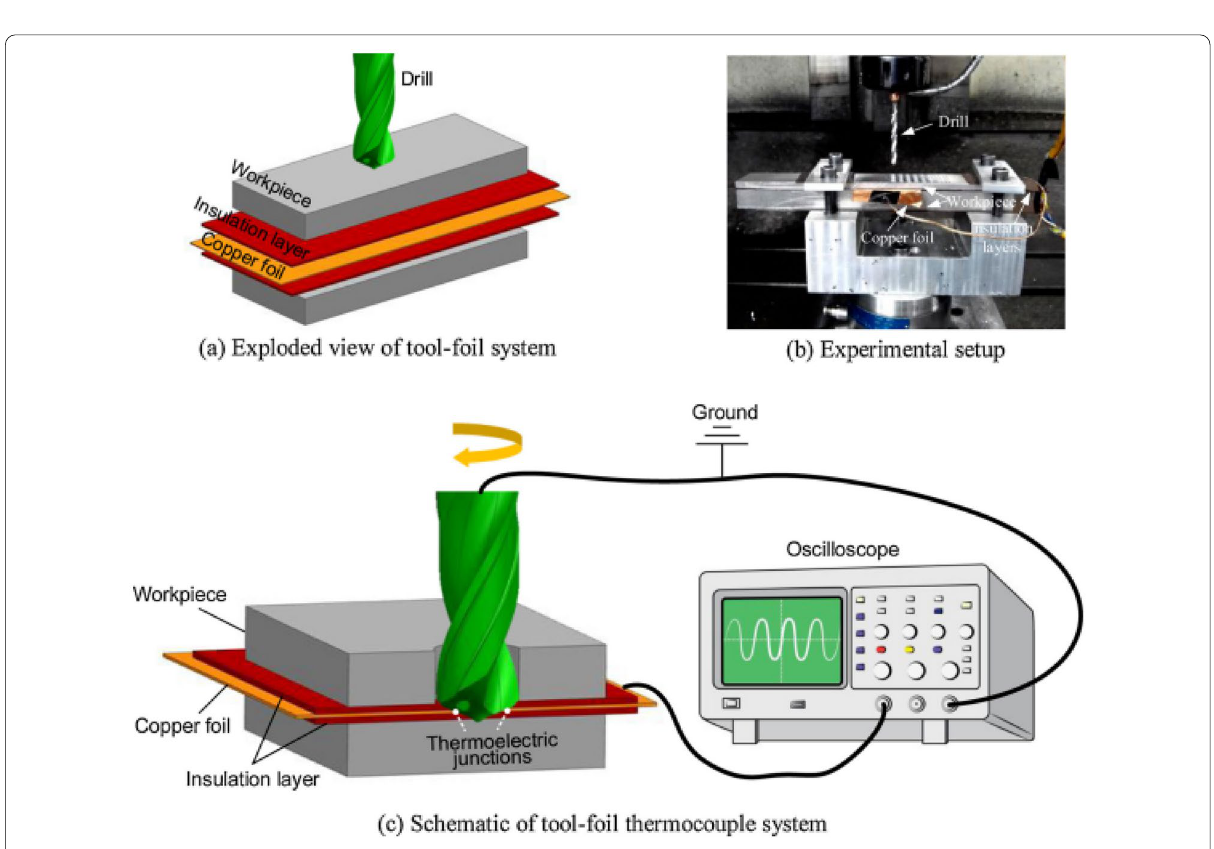
Figure 8 Schematic of tool-foil thermocouple system